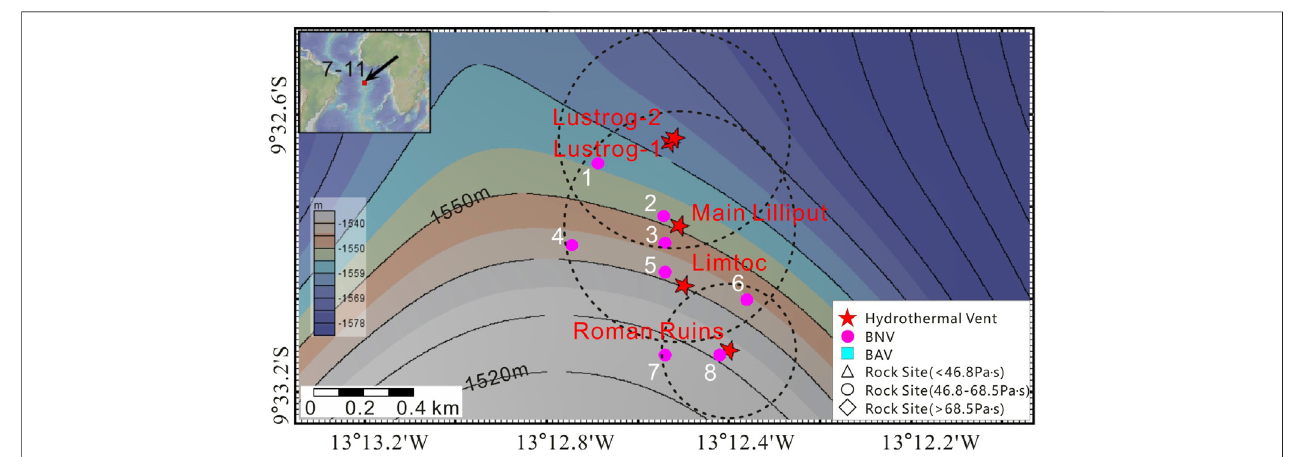
FIGURE8| BathymetricmapfromGeoMapApp,showingthelocationsofventsintheLilliputhydrothermal fi eldandthesamplesites.Blacksolidlinesarethe10 m isobaths. The symbols and color bar are described in the caption of Figure 3 .